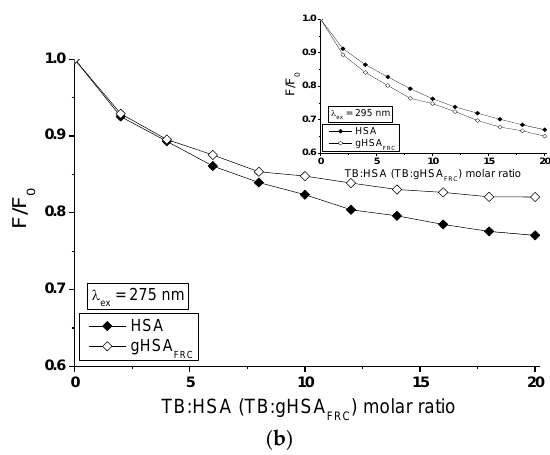
Math Symbols AMS